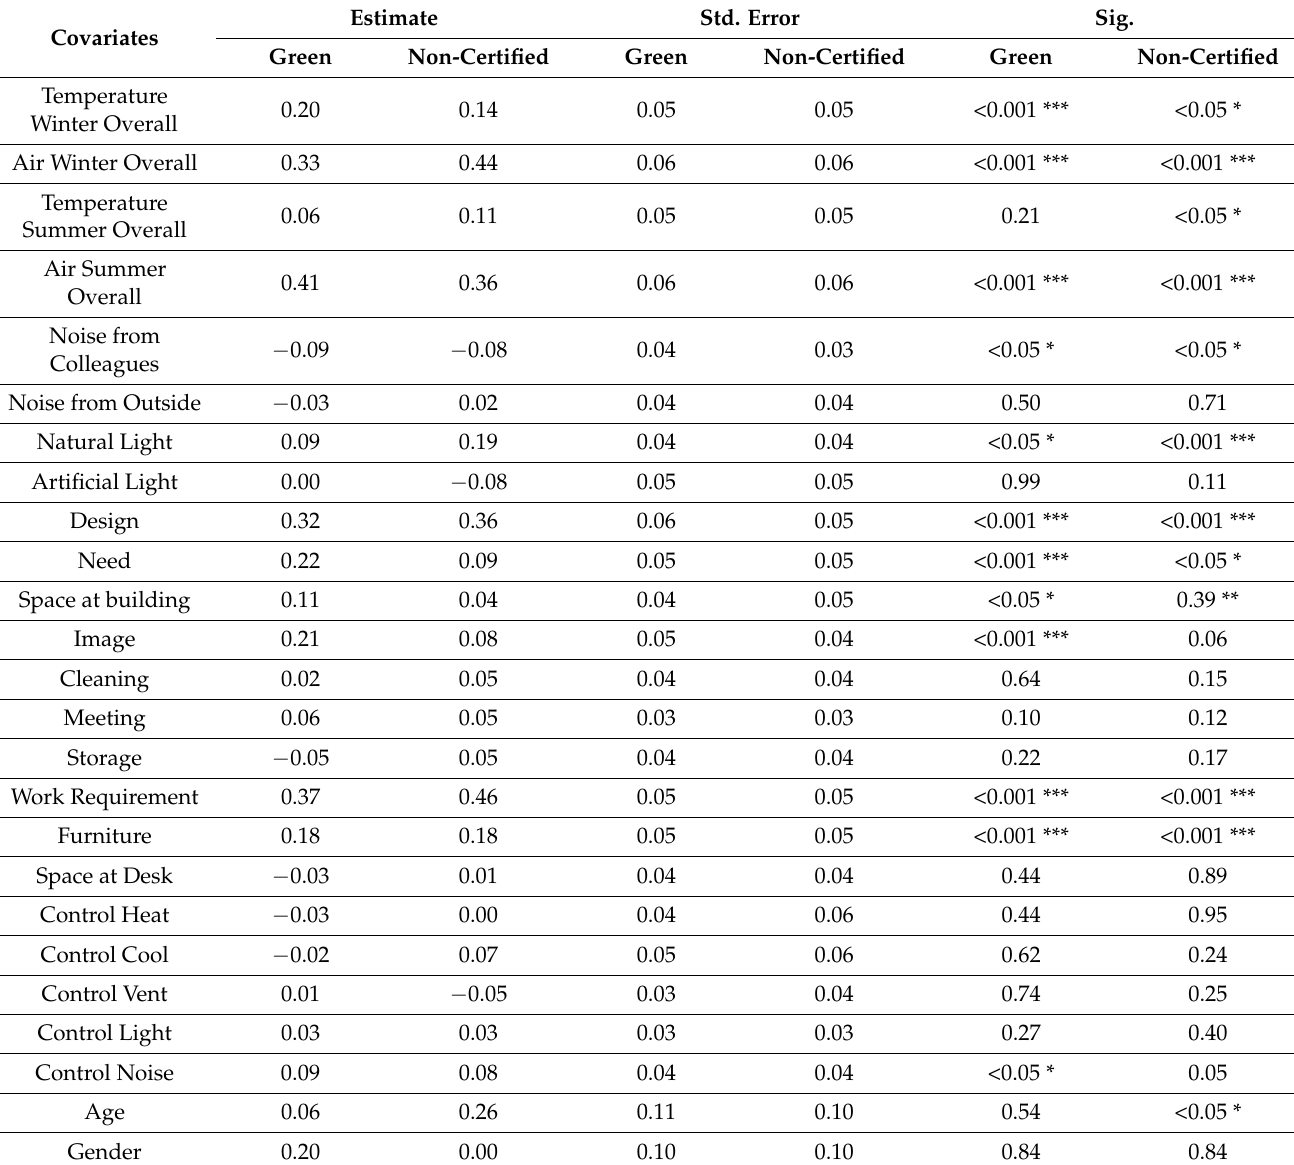
Table 9. Ordinal regression of perceived comfort comparing green and non-certified